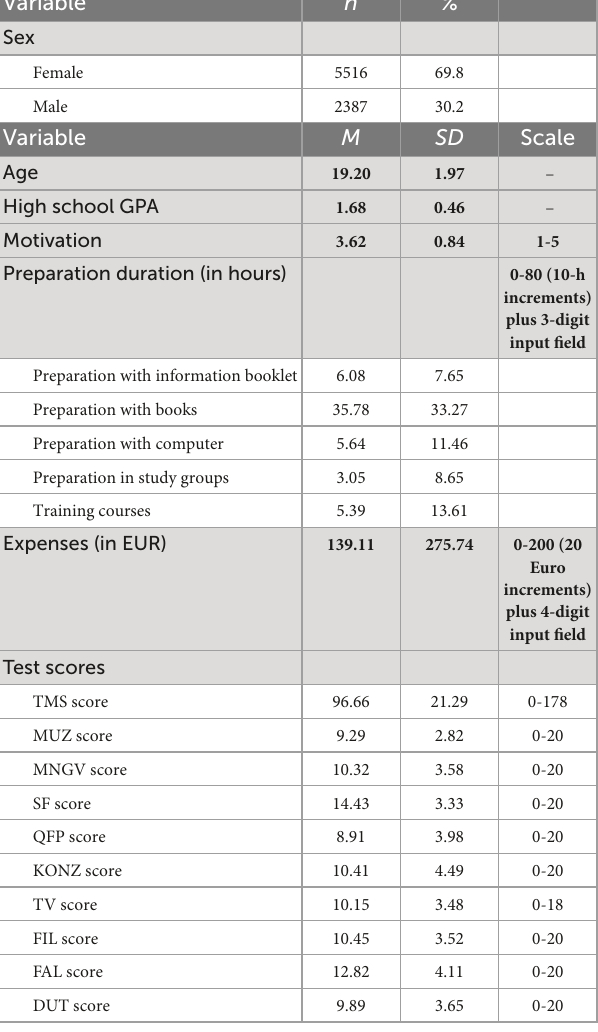
TABLE 2 Descriptive summary for all